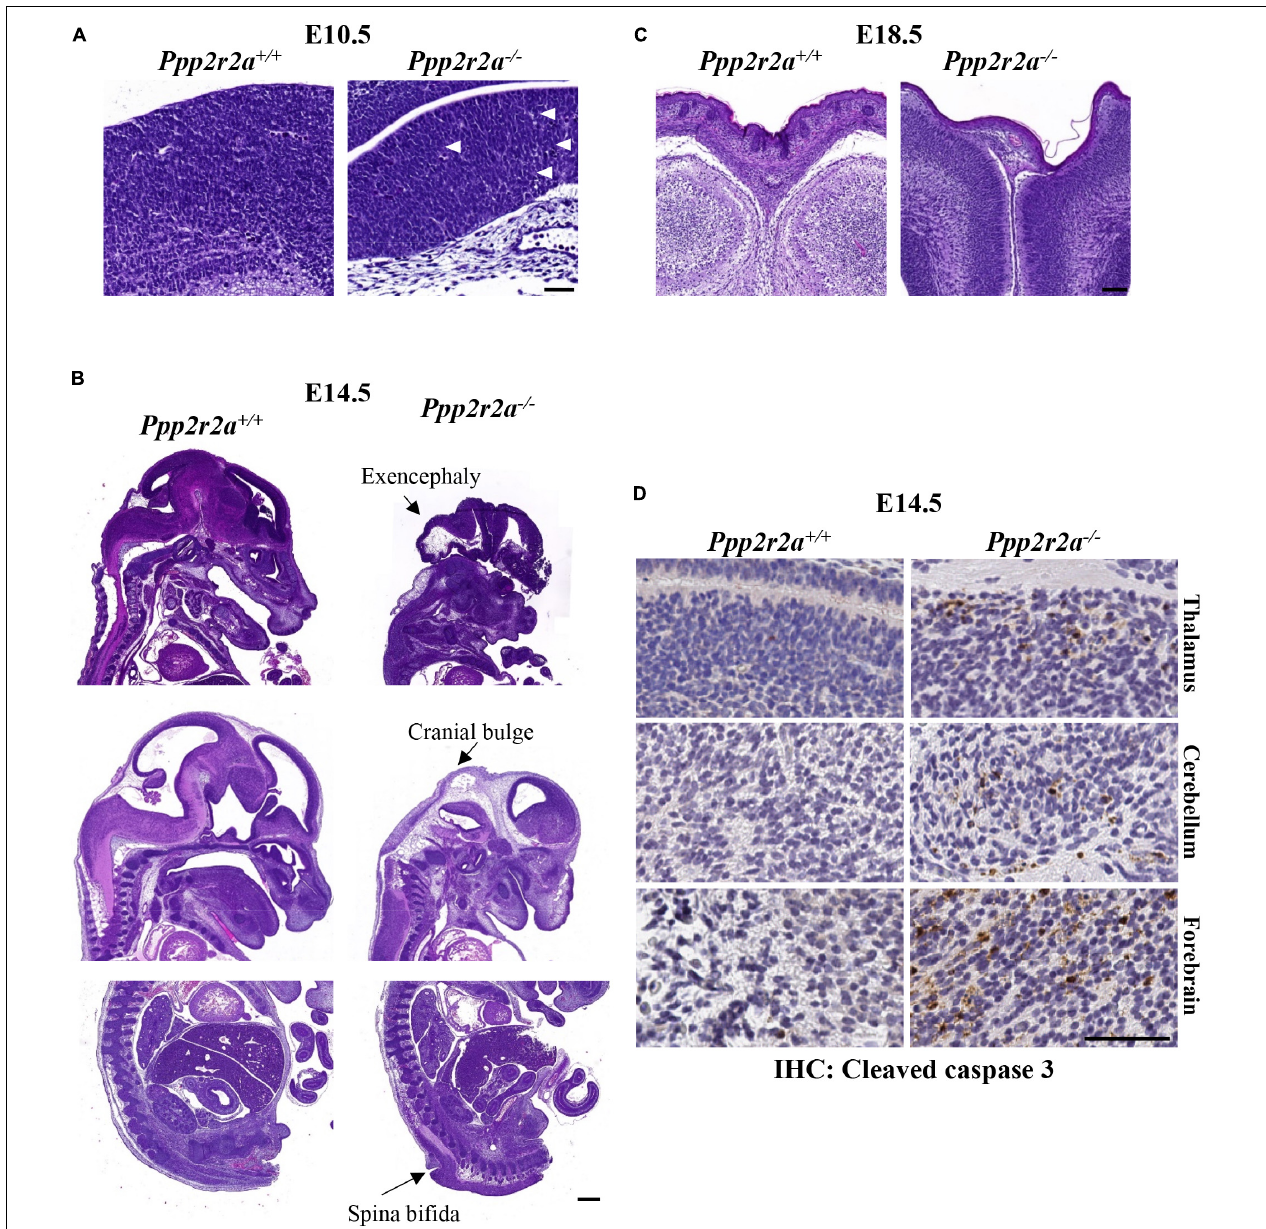
FIGURE 3 | Neural defects in Ppp2r2a knockout embryos. (A–C) H&E staining at various stages of development. (A) At E10.5, defects of the neuroepithelium consist of a lack of emerging lamination and cellular degeneration and debris (white arrows) in Ppp2r2a − / − embryos. Scale bar = 50 µ m. (B) At E14.5 the neural defects in Ppp2r2a − / − embryos include excencephaly, cranial bulging and spina bifida. Scale bar = 500 µ m. (C) At E18.5, cranial vault collapse was observed in a Ppp2r2a − / − embryo. Also evident in these sections is a thinner epidermis in the Ppp2r2a − / − embryo. Scale bar = 100 µ m. (D) IHC labeling for cleaved caspase